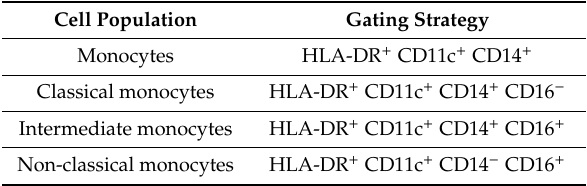
Table 2. Phenotypic strategy used to identify the di ff erent cell